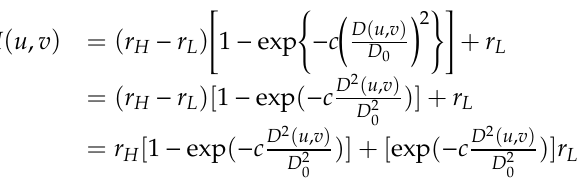
values, and ( c ) against L